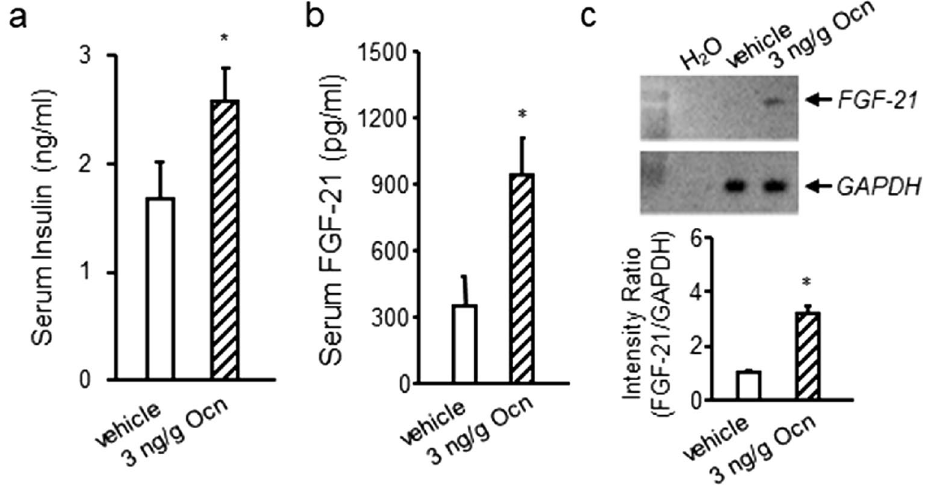
Figure 4. Effects of Ocn administration on insulin and FGF-21 in wild-type mice. Effect of Ocn administration to increase serum insulin ( a ) and FGF-21 ( b ) concentrations and liver message levels ( c ) in wild-type male mice. Values represent the mean ± SEM. *Significant difference between control group and Ocn-treated mice ( P < 0.05, Student’s t test; n =